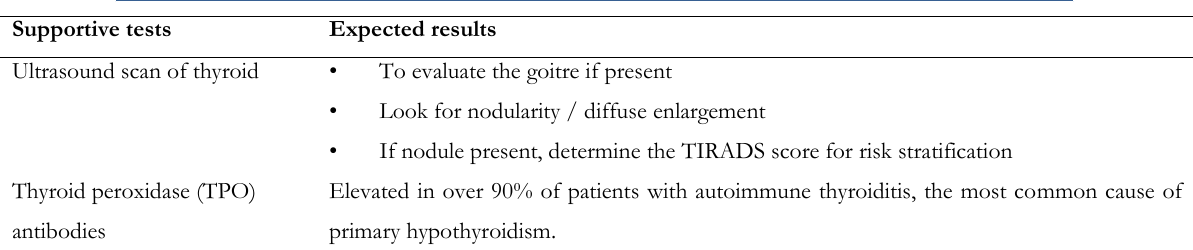
Table 2.4. Supportive tests for evaluation of